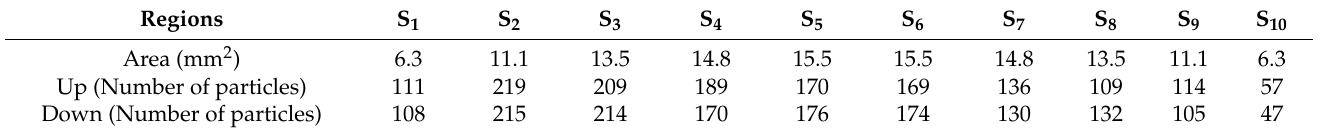
Figure 10. ( a ) Diagram of different divided regions along the radial direction of alumina-Co composite film shown in Figure 4c; ( b ) Simulation diagram of Co ion distribution on alumina-Co composite film surface; ( c ) The curve of deposition rate per unit area via divided regions. Table 3. Partition areas of the film and particle statistics at the end of 10 − 5